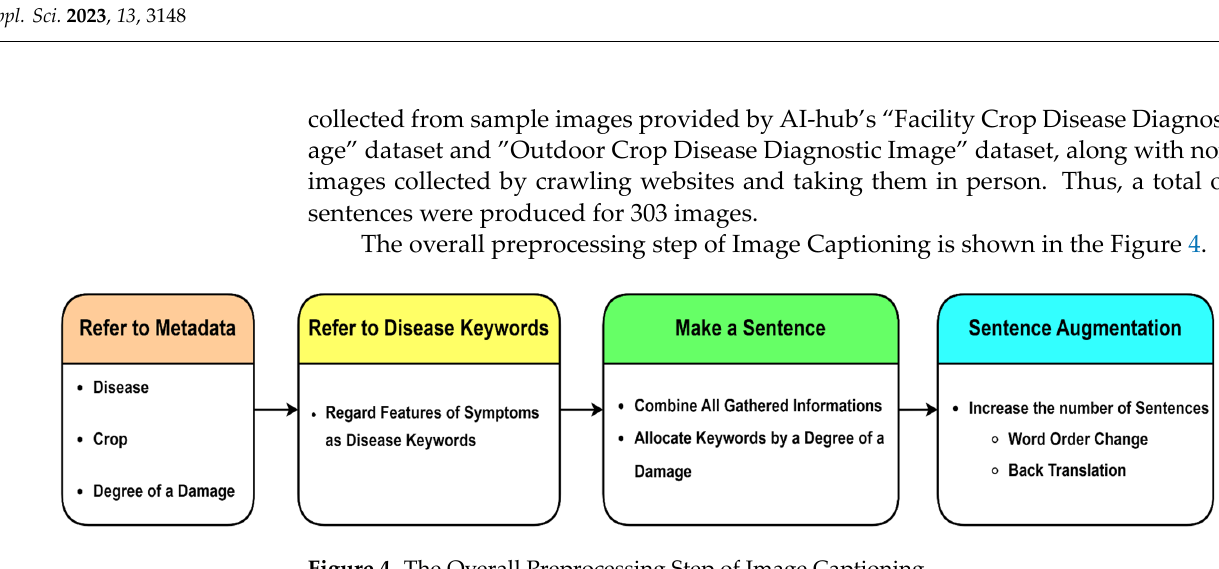
Figure 4. The Overall Preprocessing Step of Image Captioning.